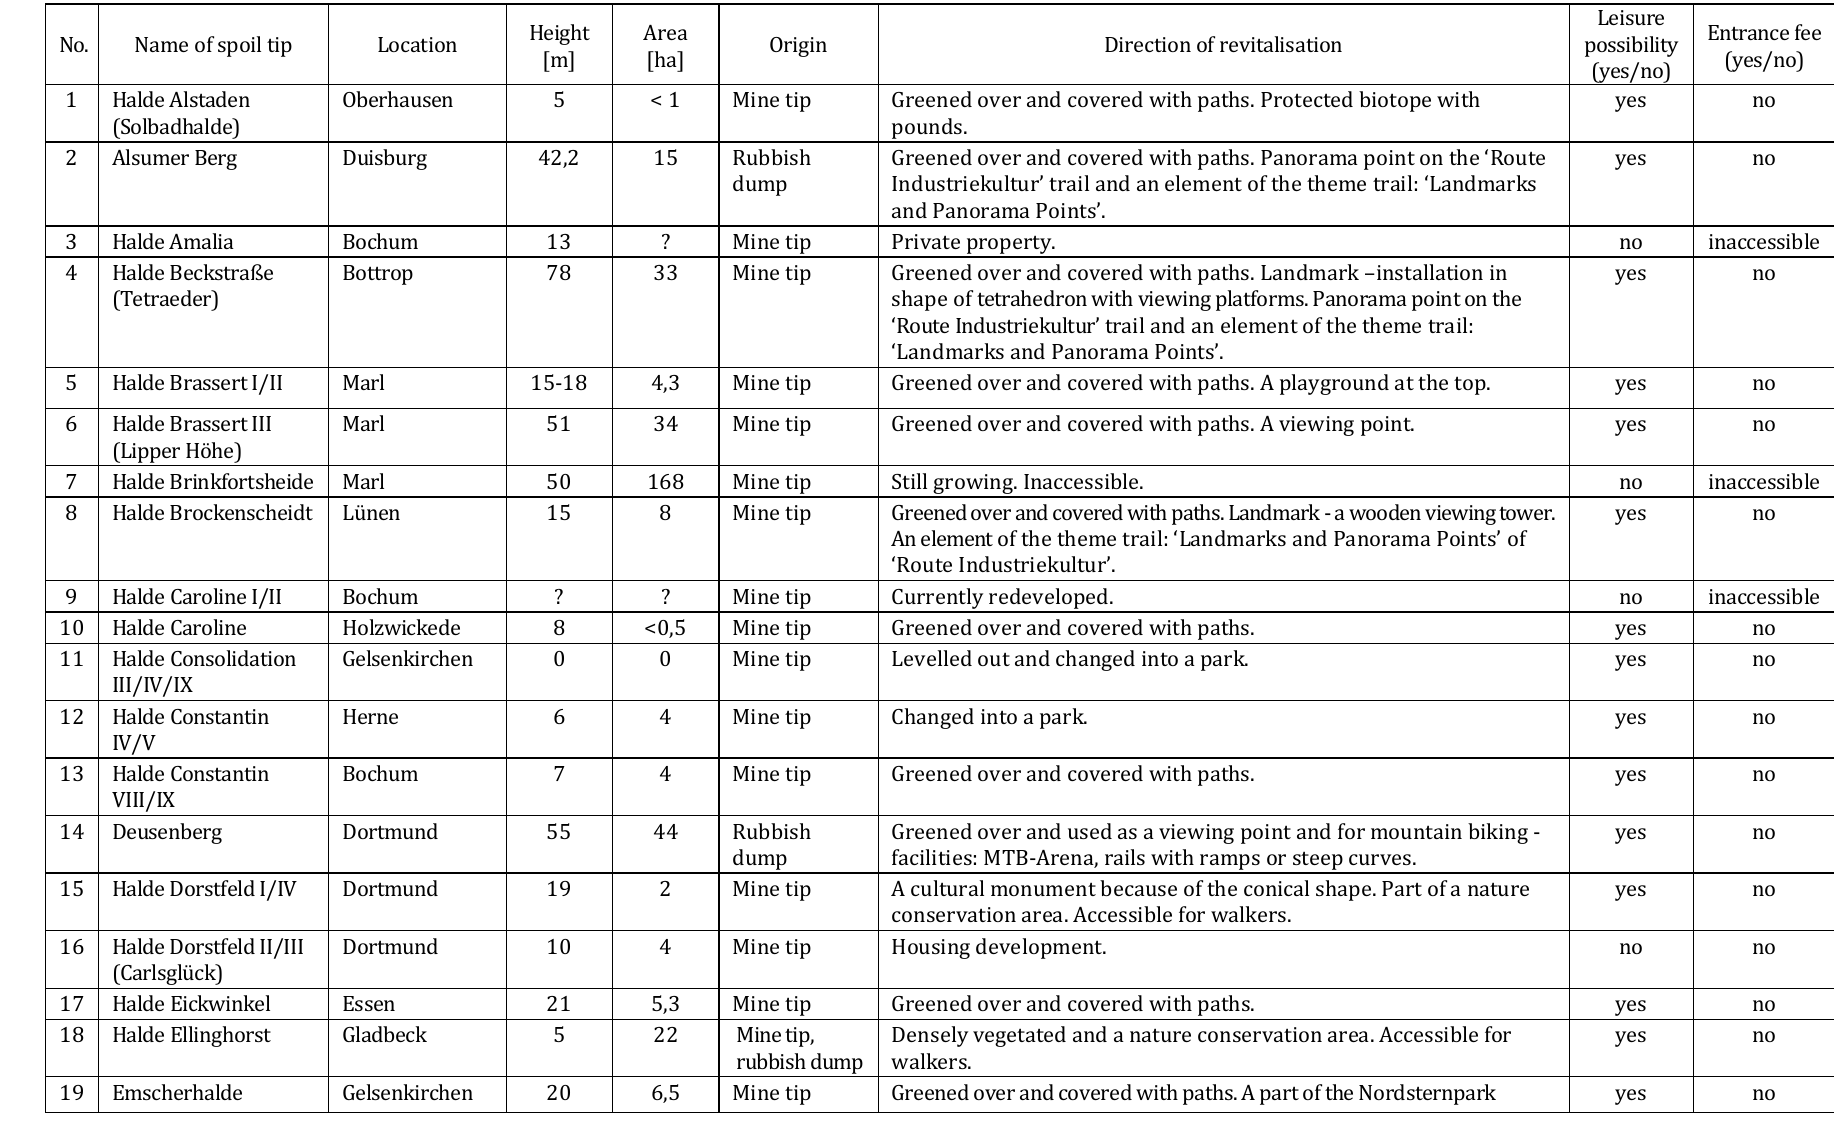
Table 1. The Direction of revitalisation of each spoil tip in the Ruhr area, Germany (own design on the basis of field studies and: www.ruhrgebiet-industriekultur.de/halden, Berke, 2011; Lange,